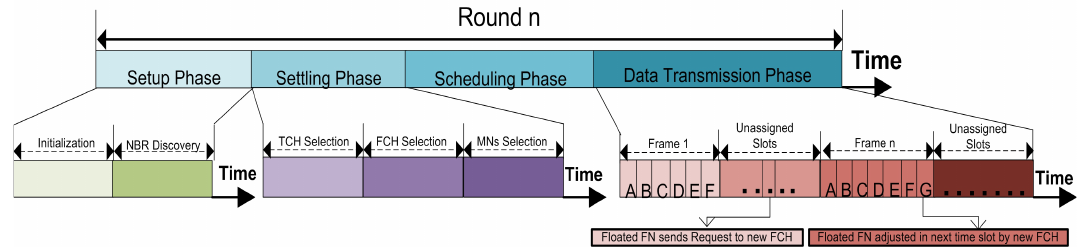
Figure 6. The description of floated FNs adjustment due to water current movements.